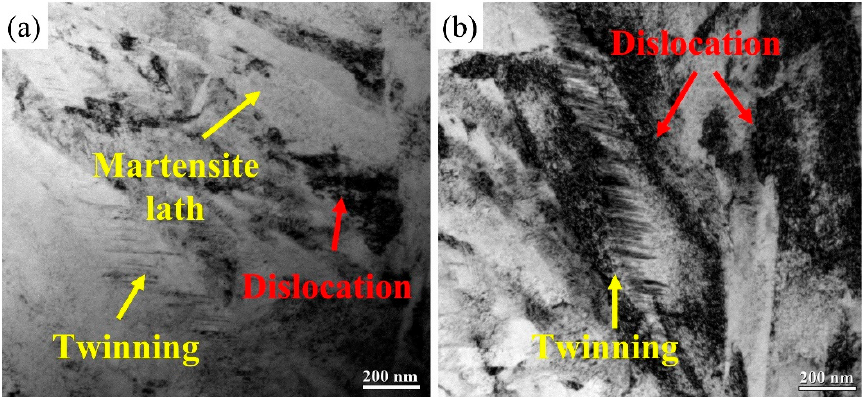
Figure 2. TEM Bright field image of the experimental steel after solution treatment at 1100 °C and 1200 °C: ( a ) 1100 °C; ( b ) 1200